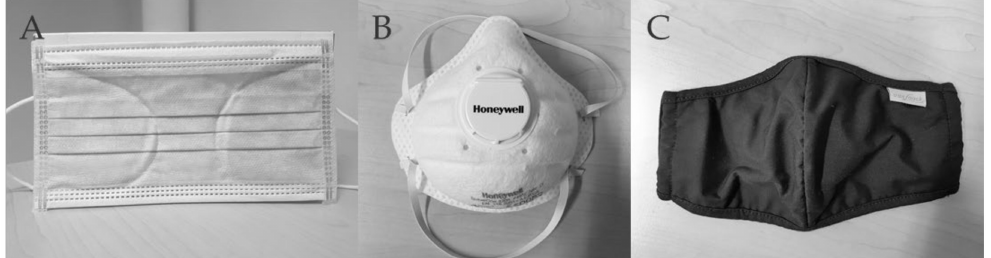
Figure 1. Investigated face masks. ( A ) MedMask medical face mask (NITRAS PROTECT, EN14683), ( B ) FFP2exhal filtering facepiece with exhalation valve (Honeywell, SuperOne 3206, VALVE, EN 149) and ( C ) community mask fabric mask (van Laack,